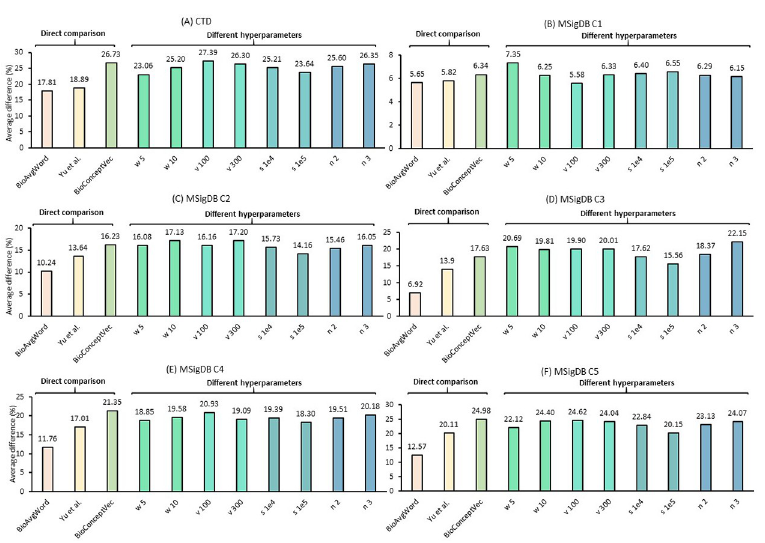
Fig 5. The intrinsic evaluation results in terms of average group similarity difference (%) for the six evaluation datasets. Direct comparison shows the results of BioConceptVec (cbow) using identical hyperparameters as the baselines. The baselines were also trained using cbow. Different hyperparameters shows the results of BioConceptVec (cbow) using different hyperparameters (provided in Table 2): w, v, s, and n stand for window size, vector dimension, sampling threshold, and negative samples,